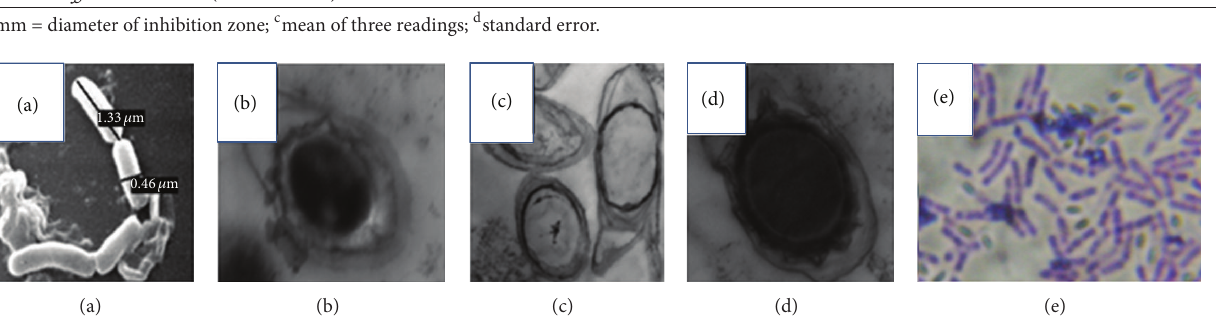
Figure 1: Electron micrographs ((a) SEM and (b)–(d) TEM) and (e) light micrograph of Bacillus sp. YAS 1 strain.